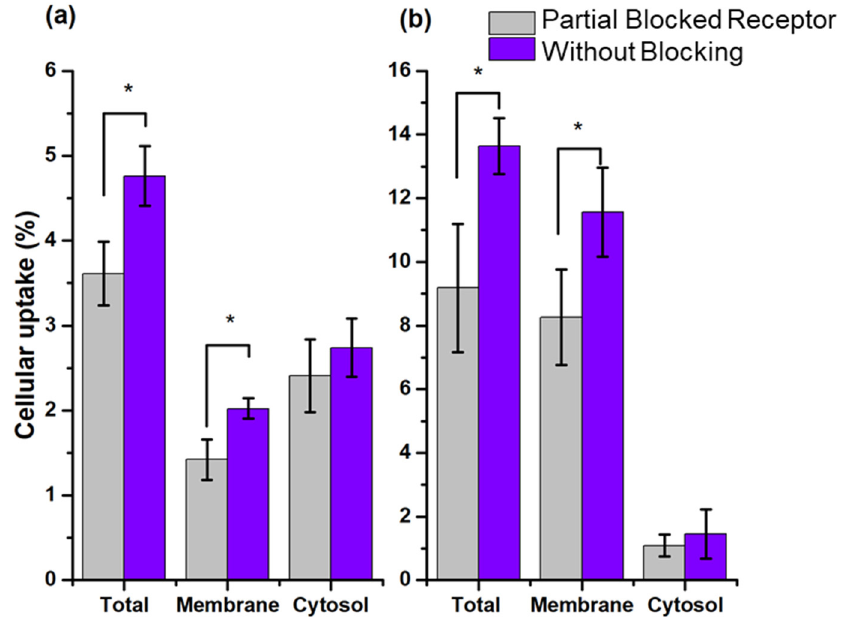
Figure 6. Cellular uptake and internalization (cytosol accumulation) (% of total activity) of ( a ) 99m Tc-HYNIC-Cholesterol and ( b ) 177 Lu-DOTA-Cholesterol in PC3 with blocked and unblocked SR-B1. Blocking of SR-B1 was performed with 7 mg/mL of empty rHDLs. * Statistically significant difference ( p < 0.05).